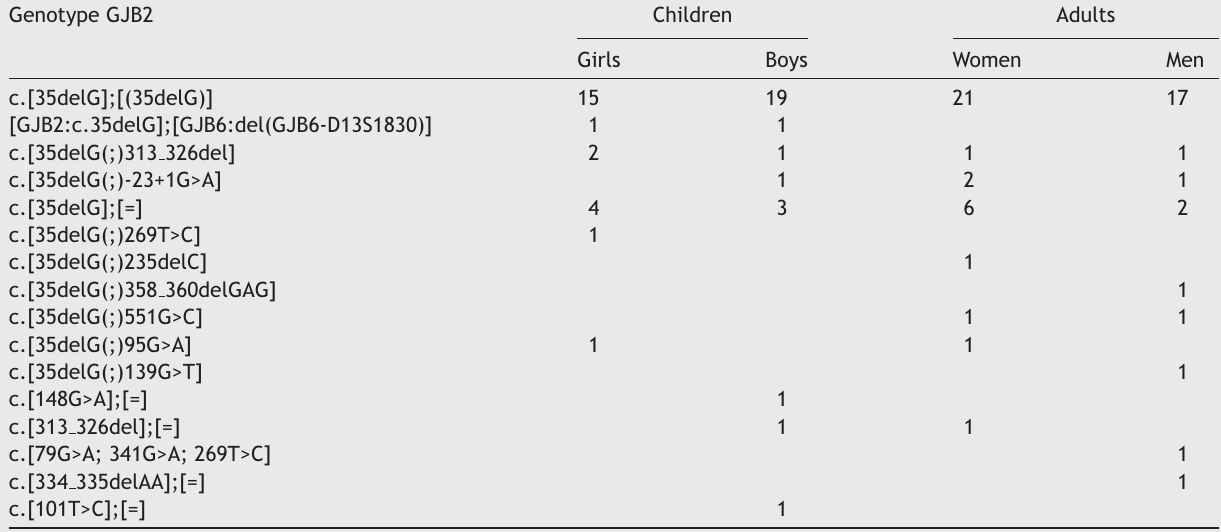
Types of genotype and their distribution in the study population.